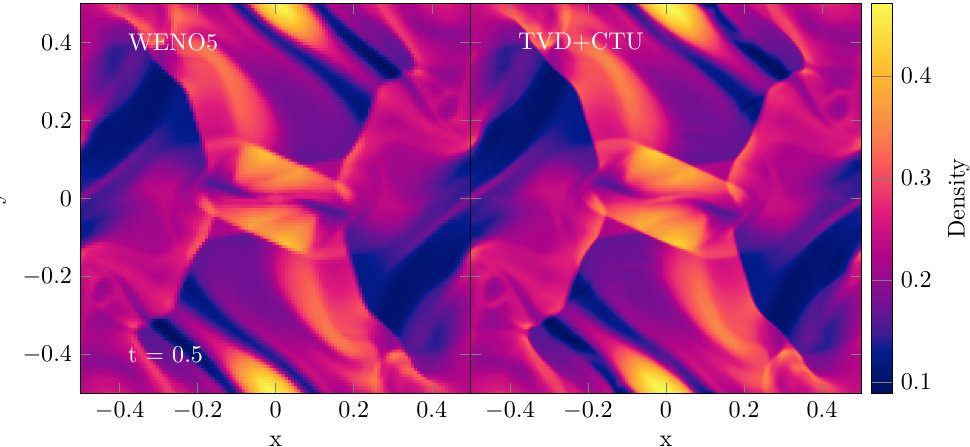
Figure 2. Density in the 2D Orszag-Tang Vortex test. Left : WENO5 solution with 128 2 zones; Right : TVD solution with 256 2 zones.